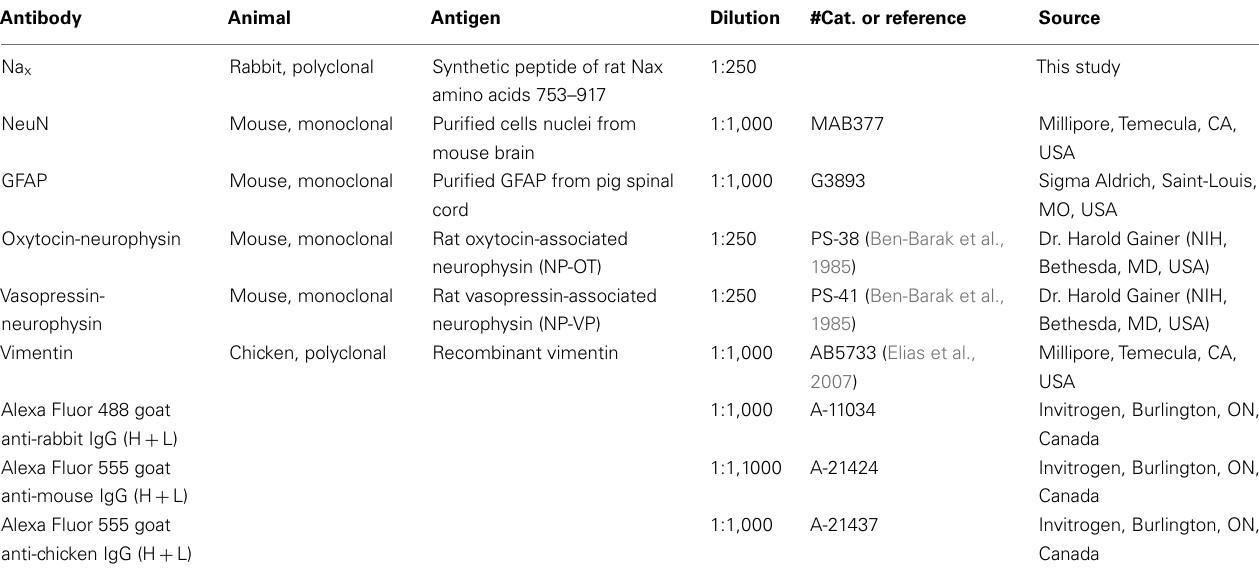
Table 1 | List of the primary and secondary antibodies used in the present study. Antibody